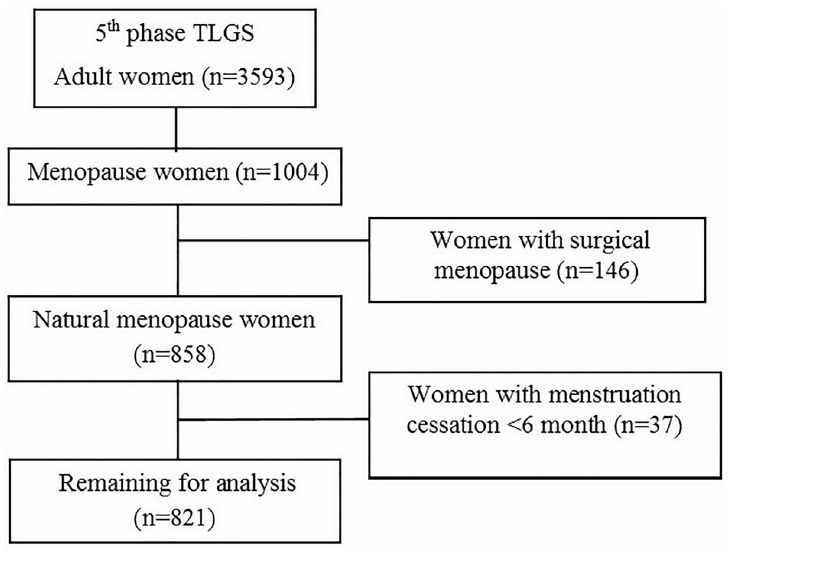
Fig 1. Selection of study